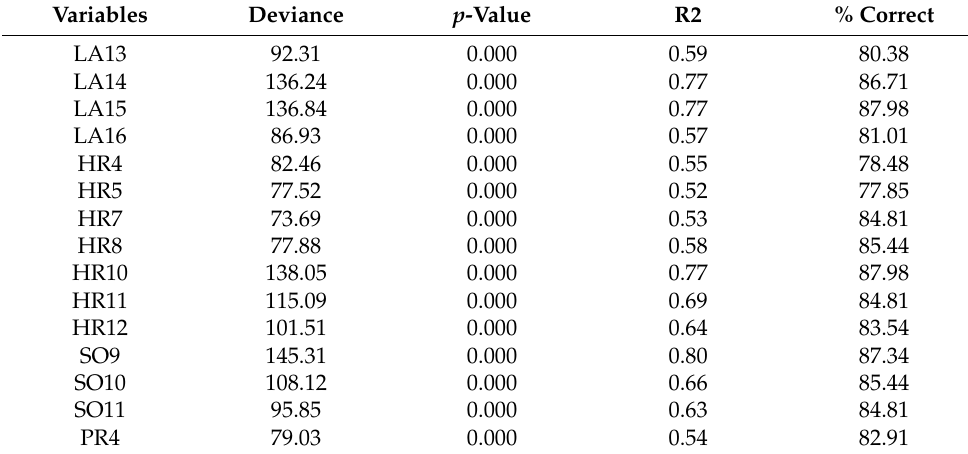
Figure 1. Frequency of disclosure of each social indicator por sub-categories. Table 3. Social indicators with higher quality of